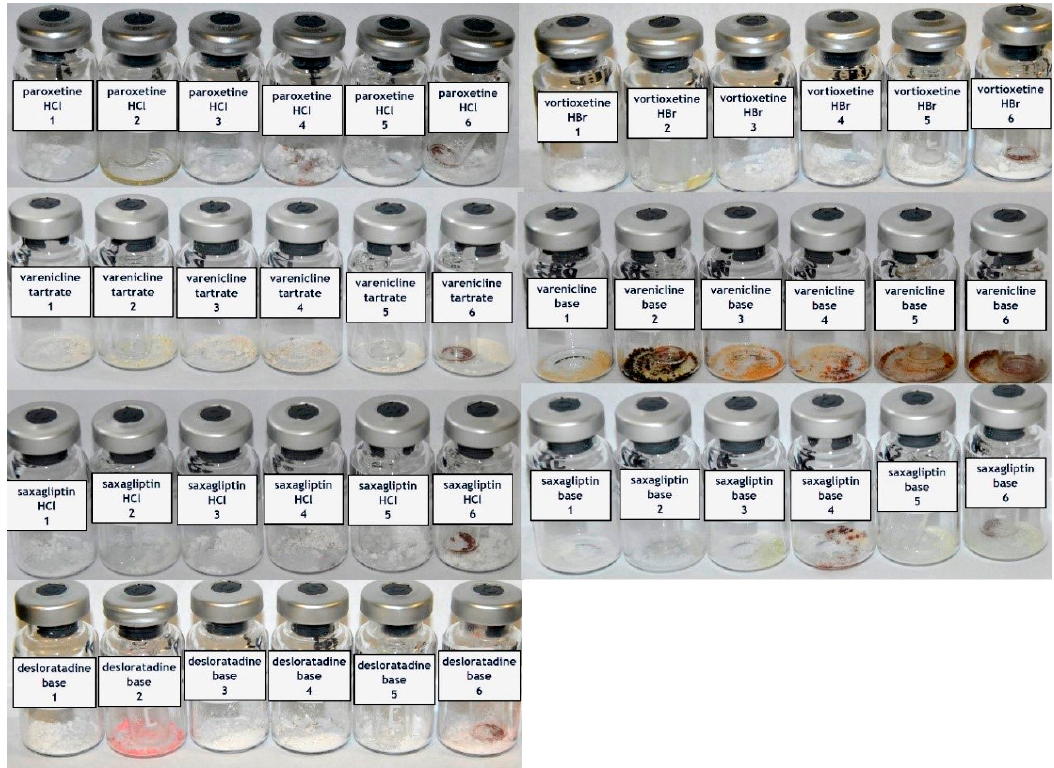
Figure 2. Photographs of samples of seven selected drug substances (137 µ moles of each) after a seven day stress test at 60 ◦ C completion. Drug substances were evaluated alone (1), in combination with formalin in a glass insert (10 µ L of 37.0% formaldehyde solution, equivalent to 134 µ moles of formaldehyde) (2), polyethylene glycol (PEG) 6000 (0.83 µ moles of PEG 6000, equivalent to 113 µ moles of ethylene glycol units) (3), and a mixture of PEG 6000 and iron oxide (Fe 2 O 3 ) (6.3 µ moles of Fe 2 O 3 , equivalent to 3.1 µ moles of Fe 2 + ions) (4). Novel compatibility setups (5) and (6) included an additional glass insert inside the 10 mL vial, where PEG 6000 (5) or a mixture of PEG 6000 and Fe 2 O 3 (6), were held separate from drug